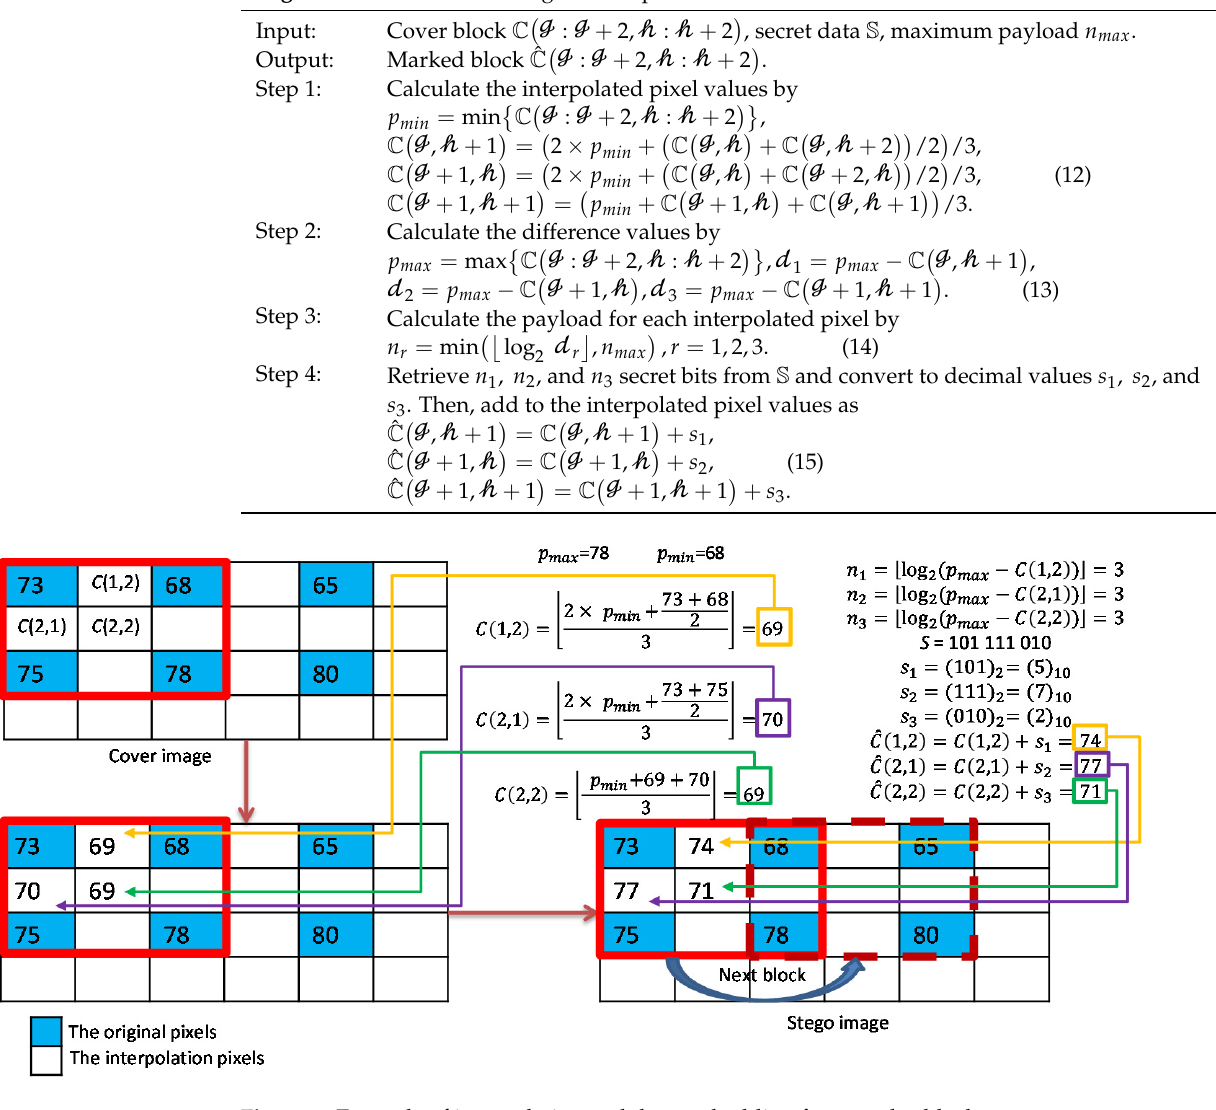
Algorithm 2 Data Embedding for Complex Blocks